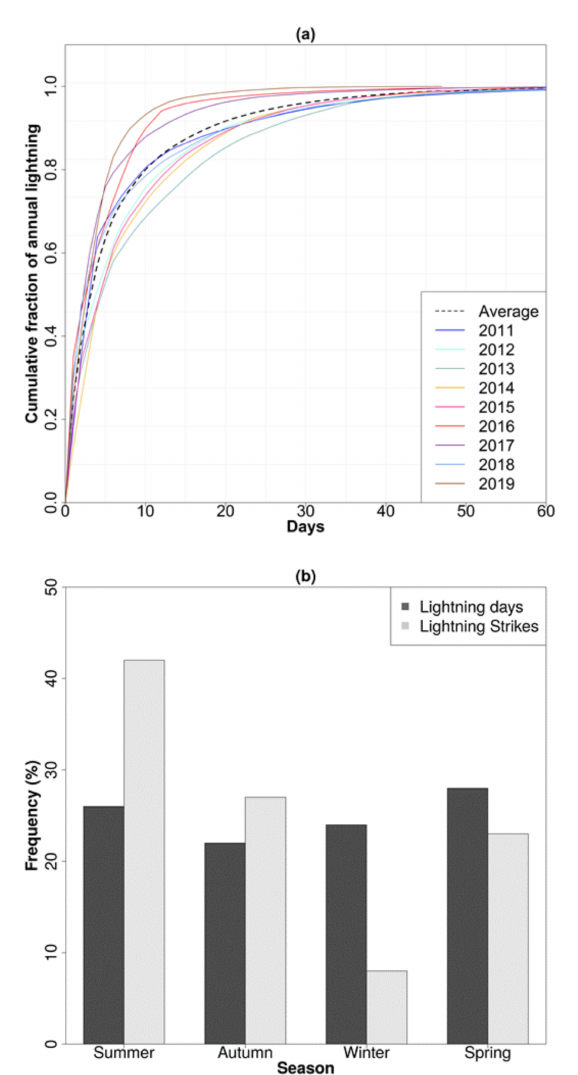
Figure 4. ( a ) Cumulative fraction of total annual cloud-to-ground (CG) lightning strikes for the days with the highest number of lightning strikes for 2011 to 2019. The dashed line displays the mean, and the solid lines display the nine individual years. ( b ) Comparison of mean seasonal variability between frequency of lightning days and lightning